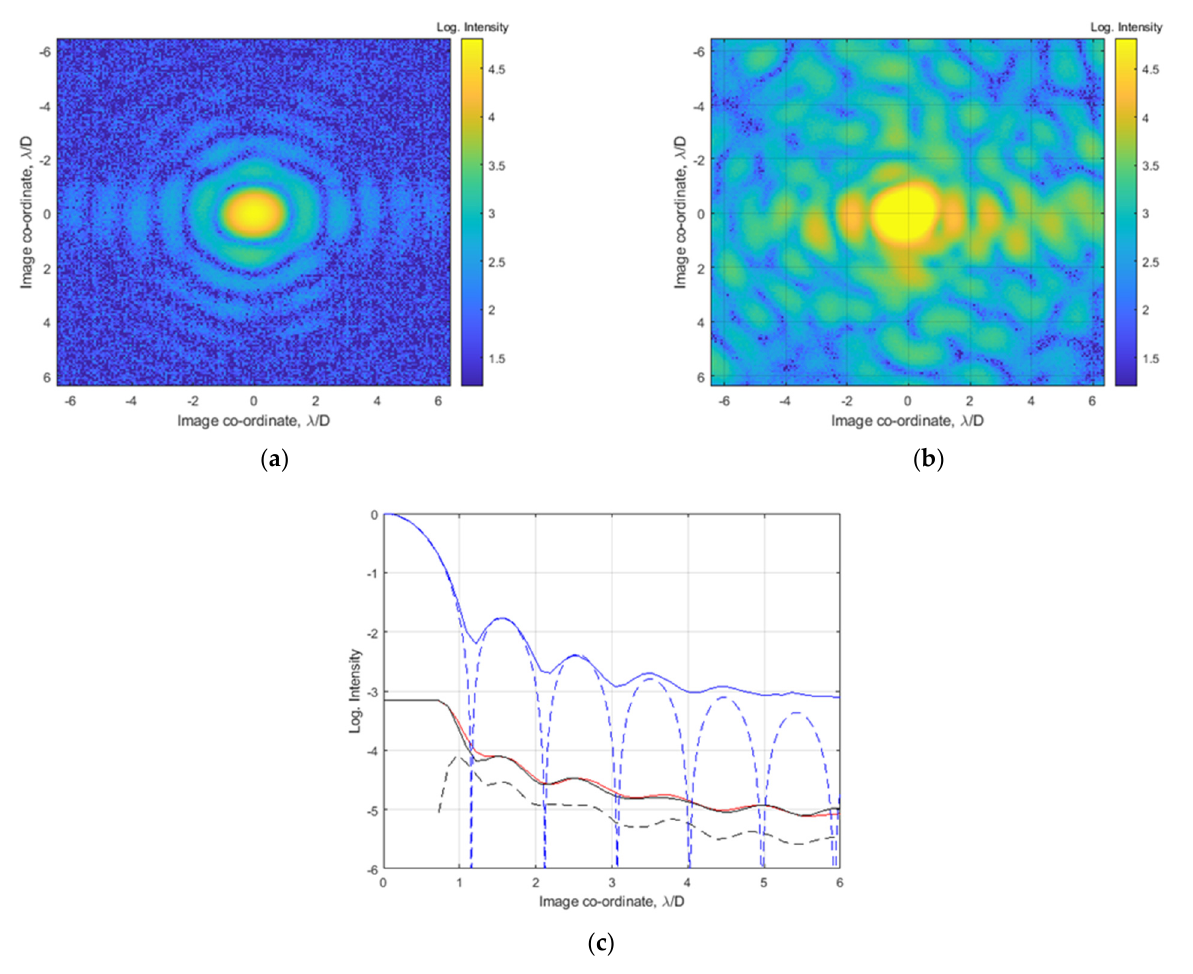
Figure 9. Experimental images: ( a )—non-coronagraphic image (with exposure 0.02 ms). ( b )—coronagraphic image by the phase correction down to with σ ≈ λ /40 (with exposure ≈ 30 ms). ( c )—averaged radial cross- sections: blue (solid) line for the non-coronagraphic image ( a ), red (solid) line for the coronagraphic image ( b ), blue (dashed) line for the radial cross-section of the theoretical PSF (non-coronagraphic), black (solid) line—cross section of another in time realization of the coronagraphic image, black (dashed) line—averaged cross section of the difference between two coronagraphic